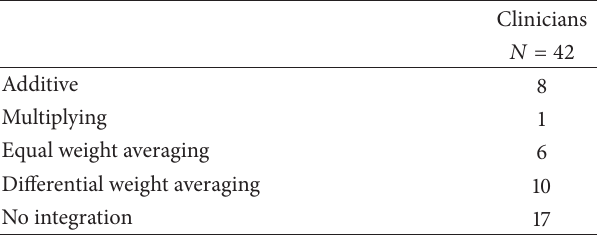
Table 2: Distribution of integration patterns across